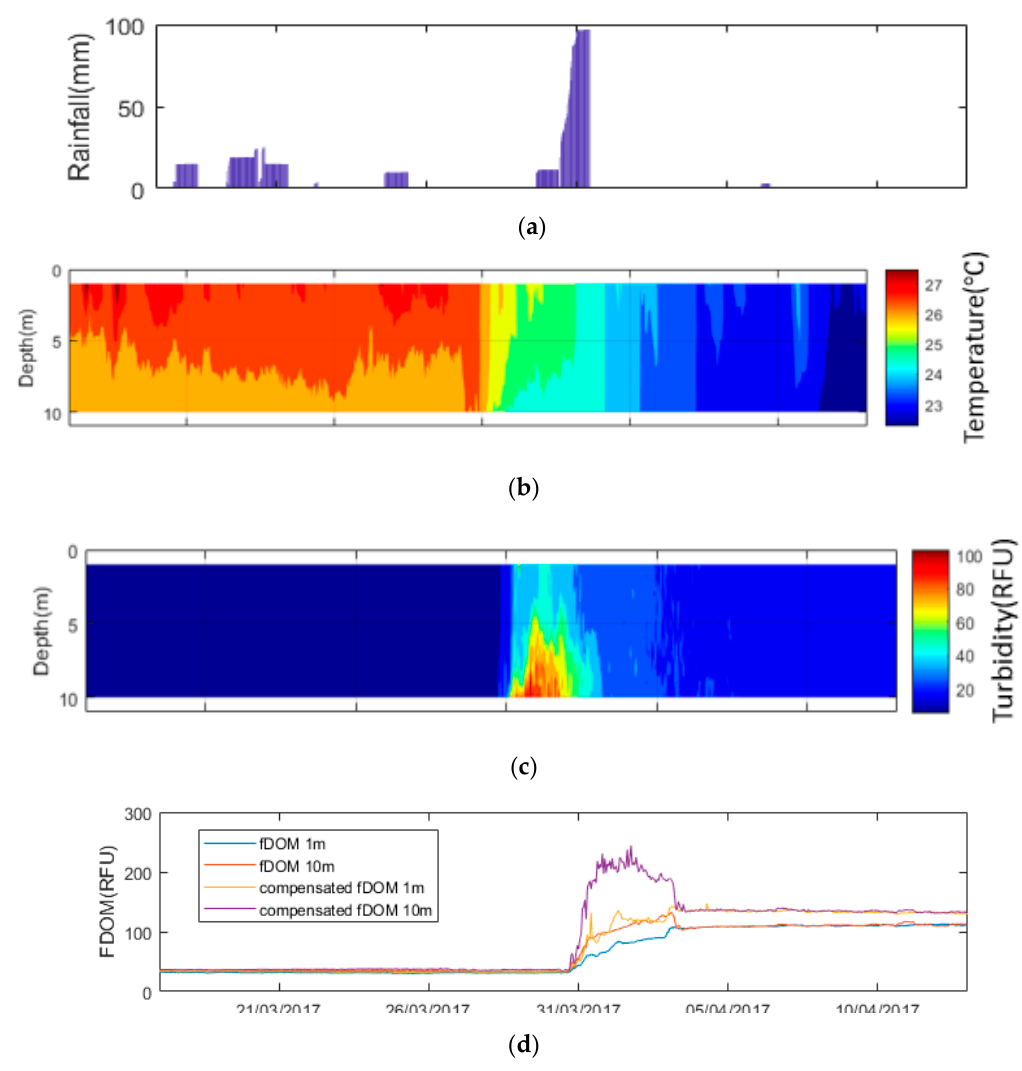
Figure 8. Precipitation and ancillary in situ VPS from 15 February to 26 February 2015 including ( a ) half hourly rainfall (mm·d − 1 ), ( b ) hourly temperature (°C), ( c ) hourly turbidity (FNU), ( d ) hourly original fDOM and compensated fDOM (RFU) at the depths of 1 m and 10 m in storm event 4.